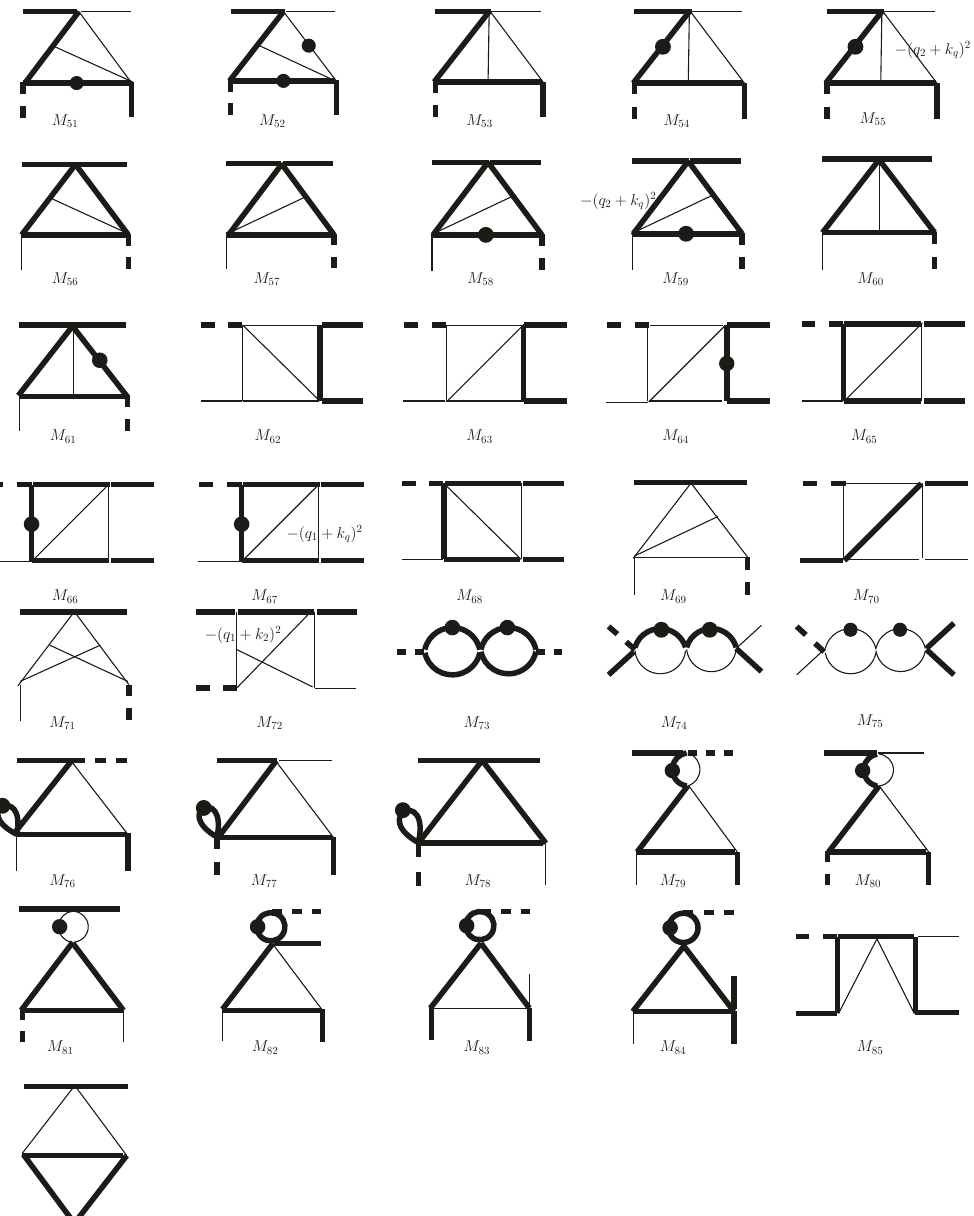
Figure 2. Set of master integrals that can be cast into canonical form and expressed in terms of GPLs. The thin lines denote massless propagators and on-shell massless external particles; the thick lines denote massive quark propagators and on-shell external quarks. The dash lines denote o(cid:11)-shell external particles with squared momentum equal to 2 ss . A dot on a propagator indicates that the power of the propagator is raised to 2. Two dots means that the propagator is raised to power